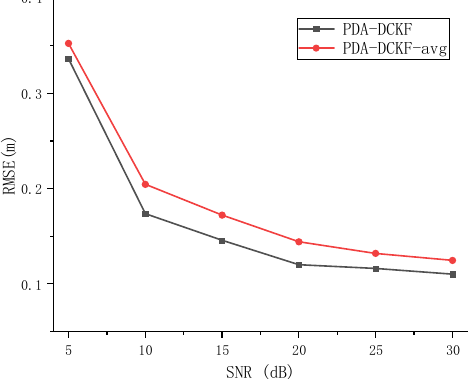
Figure 7. RMSE versus SNR for different fusion rules with T 60 = 200 ms.